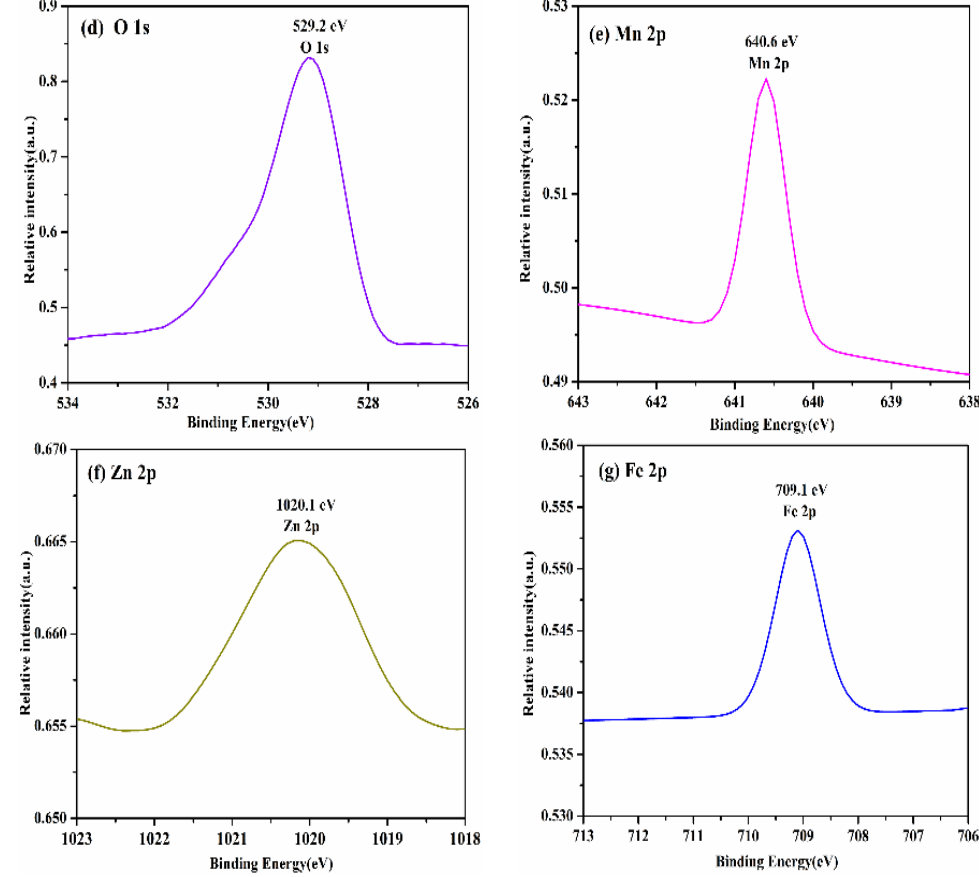
Figure 3. ( a ) X-ray photoelectron spectroscopy (XPS) survey spectra; ( b – g ) corresponding high-resolution XPS spectra of each element.